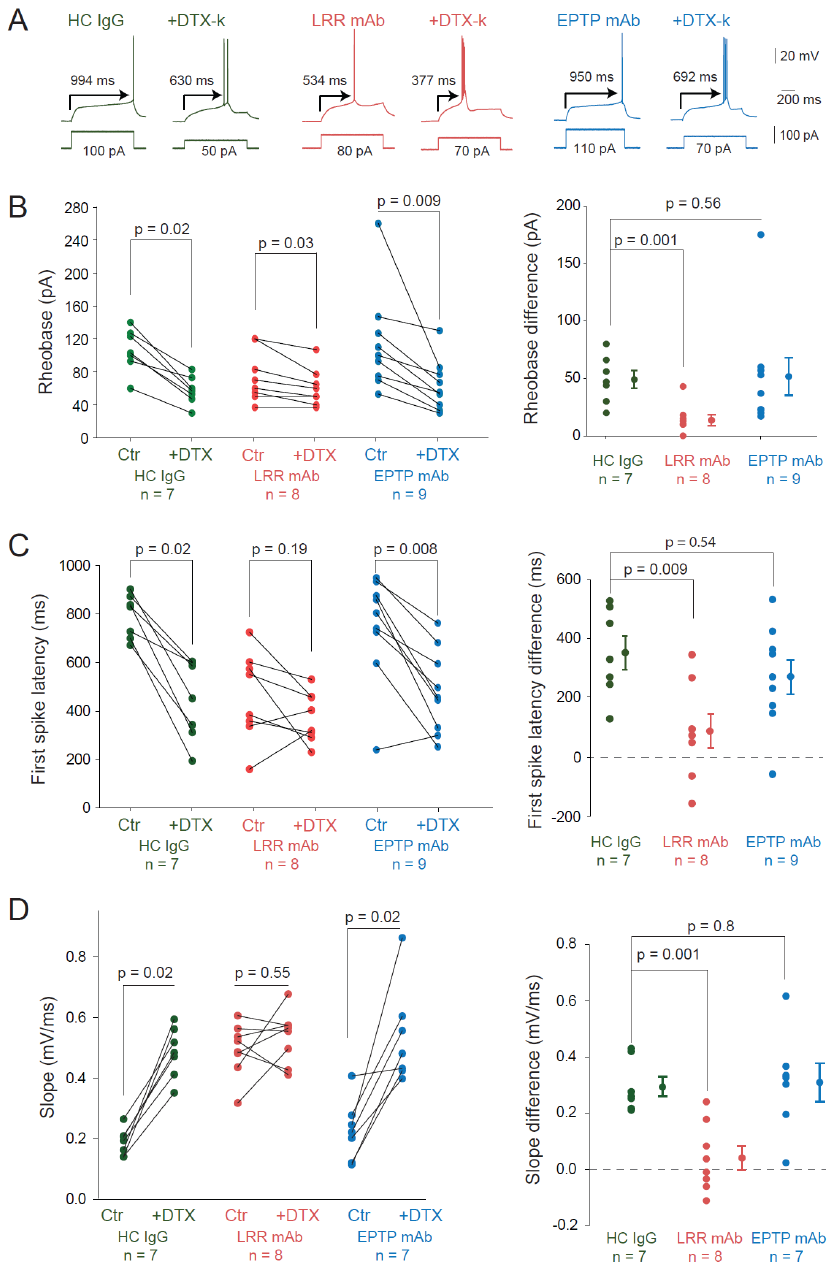
Figure 4. LRR-induced increase in intrinsic excitability is mediated by a decrease of Kv1.1 current. ( A ) The effect of DTx-k on the rheobase of neurons treated with HC IgGs (green), LRR-mAb (red), and EPTP-mAb (blue) was illustrated by the traces at the rheobase current and ( B , left ) the graphs of the rheobase current (before and after bath application of DTx-k (100 nM). ( B , right ) The effect of DTx-k was highlighted by the subtraction of the rheobase after adding DTx-k to the rheobase before DTx-k, after each antibody treatment. In the same way, the effect of DTx-k on the latency to the first spike at the rheobase current was indicated by ( A ) the arrows and reported in ( C ) the graphs, and the slope of the membrane potential trajectory before the AP was shown in ( D ) the graphs. Error bars represent SEM. Statistical analysis was performed using ( B – D left ) the Wilcoxon rank-signed test and the ( B – D right ) Mann–Whitney